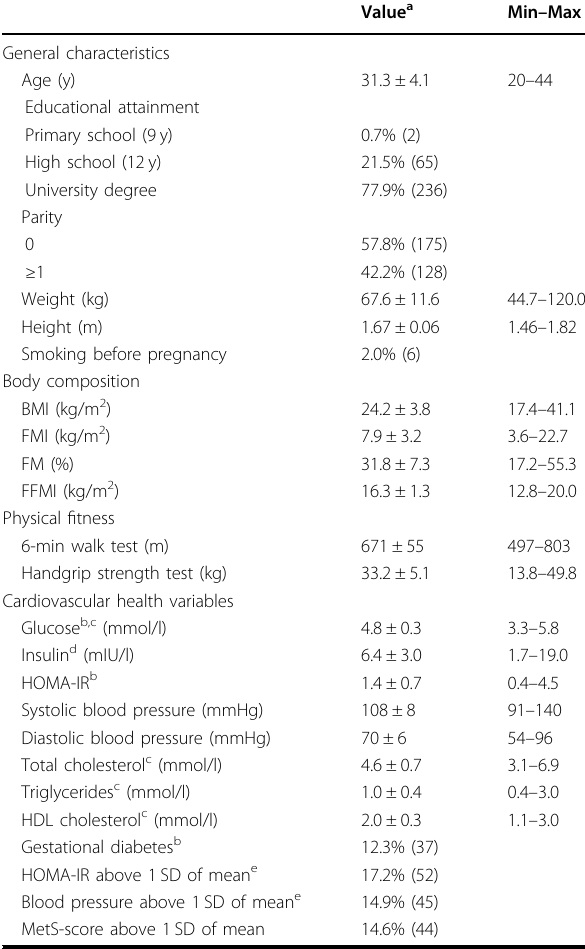
Table 1 Descriptive characteristics of the women in early pregnancy ( n =